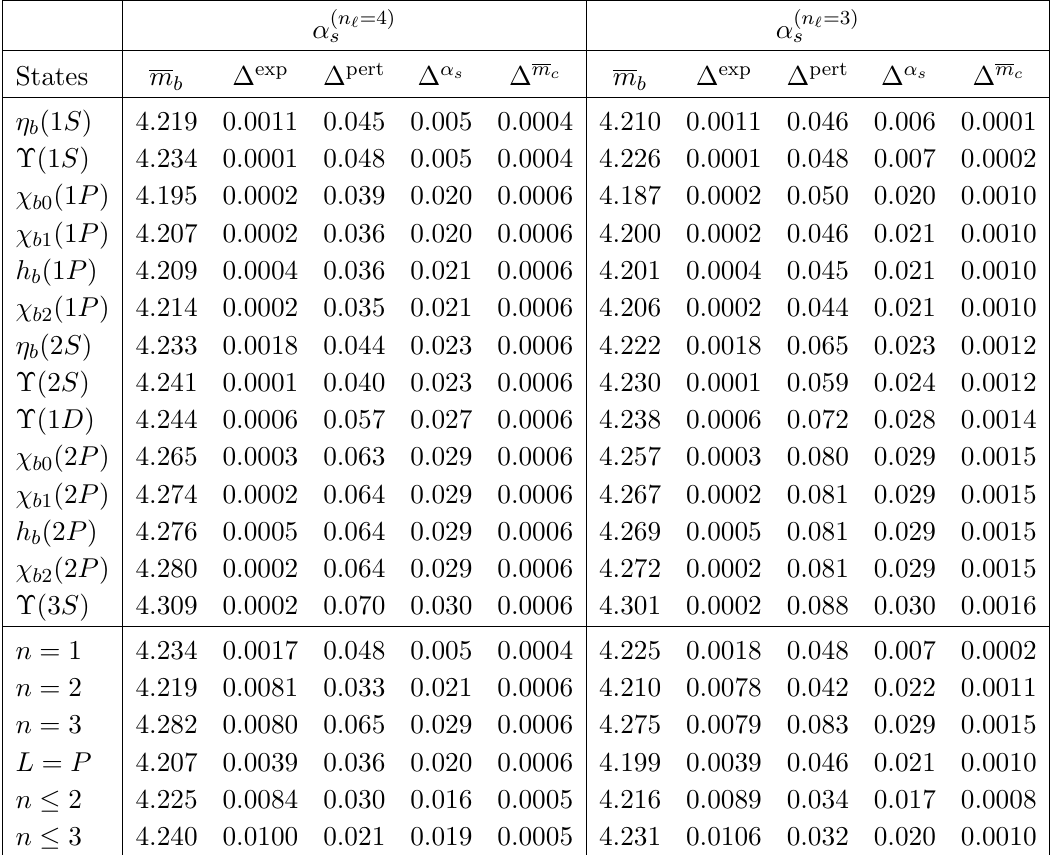
3 LO. The (cid:12)rst 14